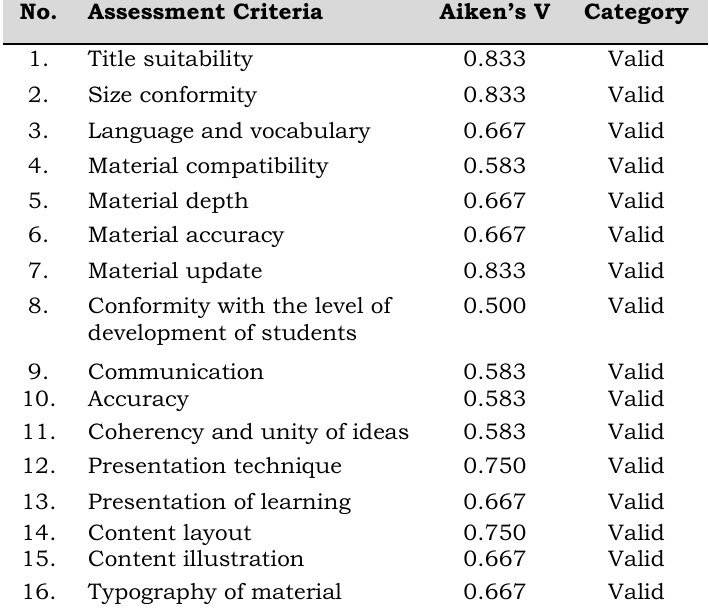
Table 4. The Aiken’s V recapitulation